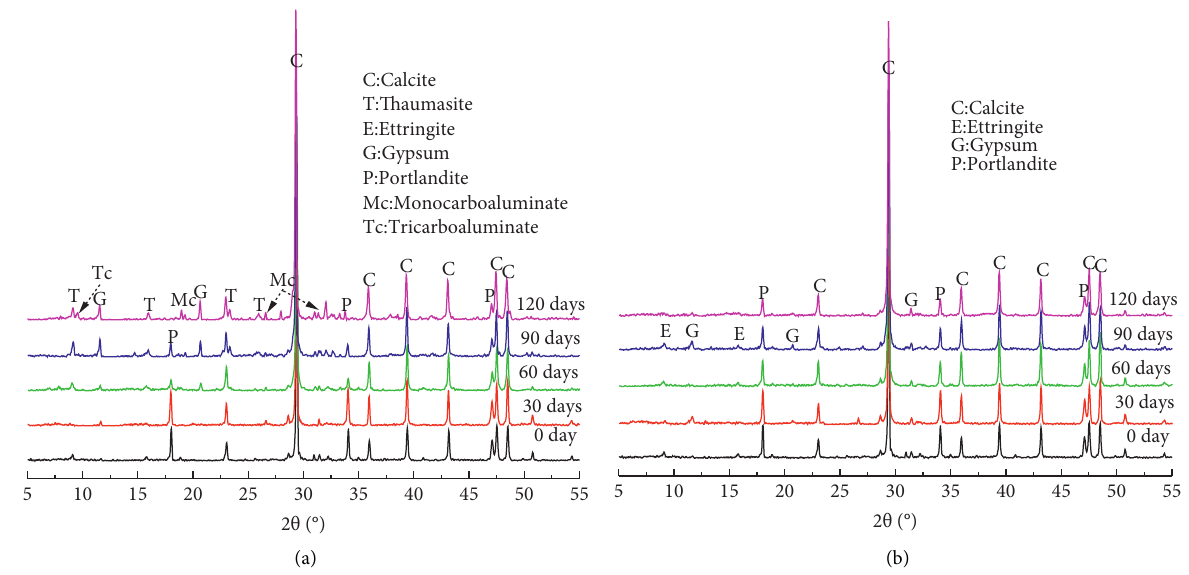
Figure 13: XRD pattern of 45% limestone powder content within 120 days. (a) Cathode surface and (b) anode